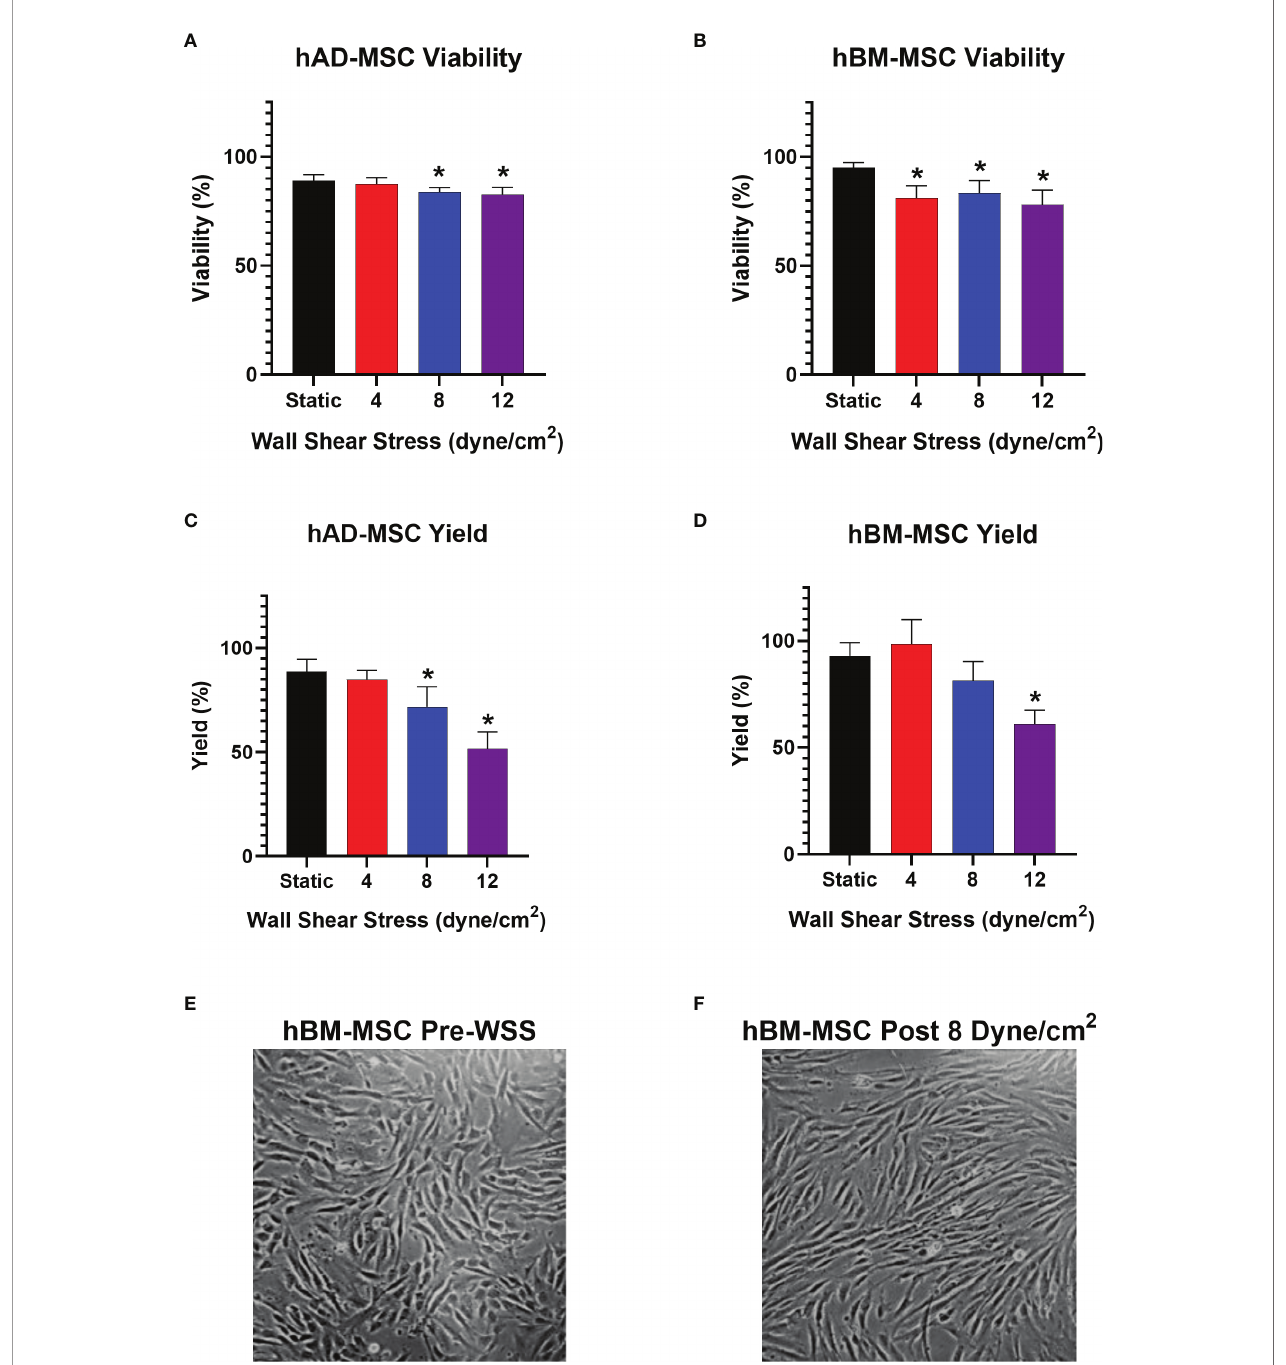
FIGURE 3 | WSS-exposure impacts cellular yield, without affecting MSC viability. (A) Viability of harvested hAD-MSC after exposure to 4, 8, or 12 dyne/cm 2 compared to static control culture (n=5 independent experiments; one-way ANOVA with Tukey ’ s multiple comparison test, *p<0.05 versus static group). Data represent Mean ± SD. (B) Viability of harvested hBM-MSC after exposure to 4, 8, or 12 dyne/cm 2 (n=5 independent experiments for all groups, except n=4 in static group; one-way ANOVA with Tukey ’ s multiple comparison test, *p<0.05 versus static group). (C) Percent yield of hAD-MSC collected after exposure to 4, 8, or 12 dyne/cm 2 compared to static control culture (n=5 independent experiments for all groups, except n=4 in 4 dyne/cm 2 group; one-way ANOVA with Tukey ’ s multiple comparison test, *p<0.05 versus static group). (D) Percent yield of hBM-MSC collected after exposure to 4, 8, or 12 dyne/cm 2 compared to static control culture (n=5 independent experiments for all groups, except n=4 in 4 dyne/cm 2 group; one-way ANOVA with Tukey ’ s multiple comparison test, *p<0.05 versus static group). (E, F) Phase microscopy image (10x) taken 3 hrs after injecting hBM-MSC into fi bronectin-coated bioreactor and after exposure to 8 dyne/cm 2 for 3 hrs,